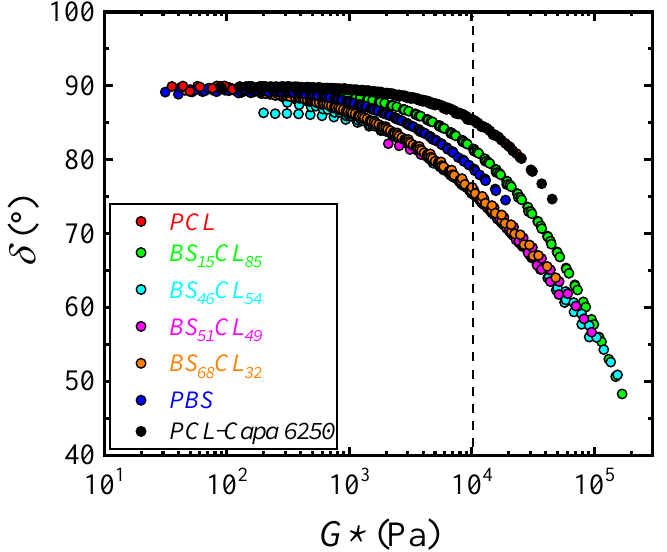
Figure 5. Mavridis-Schrof-Van Gurp-Palmen plots for the synthesized PBS- ran -PCL copolymers and commercial PCL Capa-6250. The vertical dash line at | G * |= 10 4 Pa is drawn for the purpose described in the text.